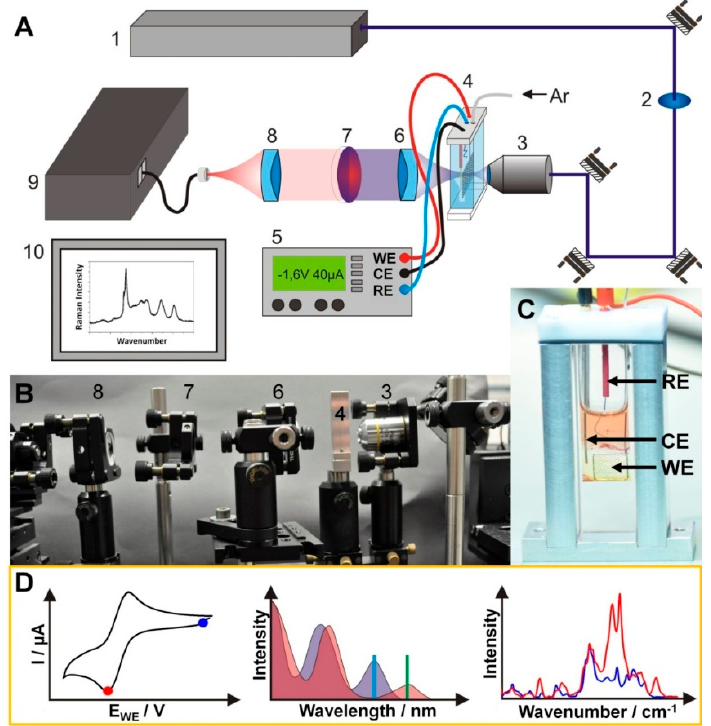
Figure 5. ( A ) Schematic representation and ( B ) a photograph of the measuring setup including an Argon ion Laser (1), laser line bandpass filter (2), a microscope objective (3), the SEC cell (4), a potentiostate (5), UV-vis achromatic optics (6,8), longpass filter (7), spectrometer (9), and a computer (10). ( C ) Photograph of the thin-layer SEC-cell within the custom-made holder, RE: Ag/AgCl reference electrode, CE: Platinum counter electrode, WE: Platinum networking electrode. ( D ) The principle of a SEC measurement starts with recording a CV ( D , left ) either directly in the thin-layer SEC cell or in a conventional electrochemistry cell to determine the redox potential of the analyte. The applied potential for the acquisition of UV-vis and Raman spectra are marked with a blue or a red point in the CV. Subsequently the analyte is investigated by UV-Vis- ( D , middle ) and resonance Raman ( D , right ) spectro-electrochemistry (the blue spectra are recorded at open circuit potential, the red spectra are recorded at a certain redox potential). RR excitation wavelengths are displayed as vertical lines in the UV-vis spectra ( D , middle ).